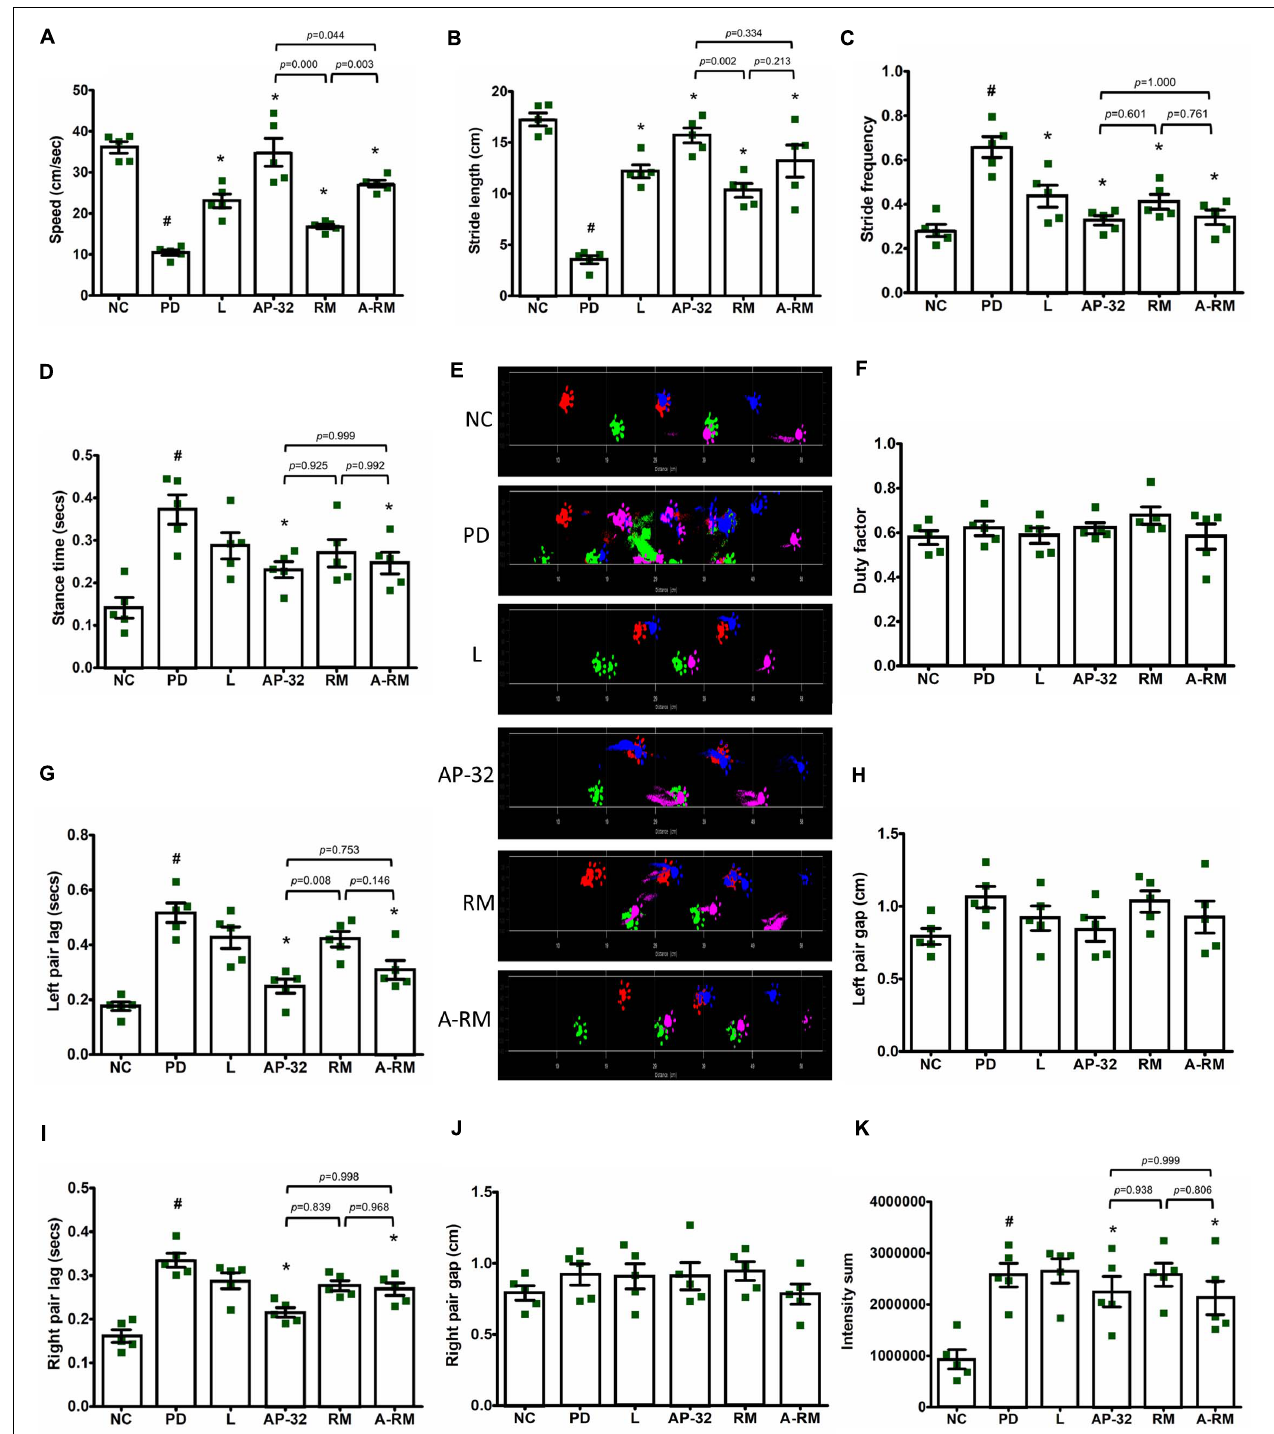
FIGURE 3 | Dynamic parameters for gait analysis in 6-OHDA-induced PD rats. (A) Speed started from entering until leaving the walkway. (B) Stride length. (C) Stride frequency. (D) Stance time. (E) Section from original footprints recorded after 8-weeks supplementations; pink, front left; blue, front right; green, hind left; red, hind right. (F) Duty factor. (G) Left pair lag. (H) Left pair gap. (I) Right pair lag. (J) Right pair gap. (K) Intensity sum. All data are expressed as mean ± SEM ( n = 5 rats/group). # p < 0.05 PD group compared to NC group. * p < 0.05 L, AP-32, RM, and A-RM groups compared to PD group. Data were evaluated by one-way ANOVA with Tukey’s post hoc